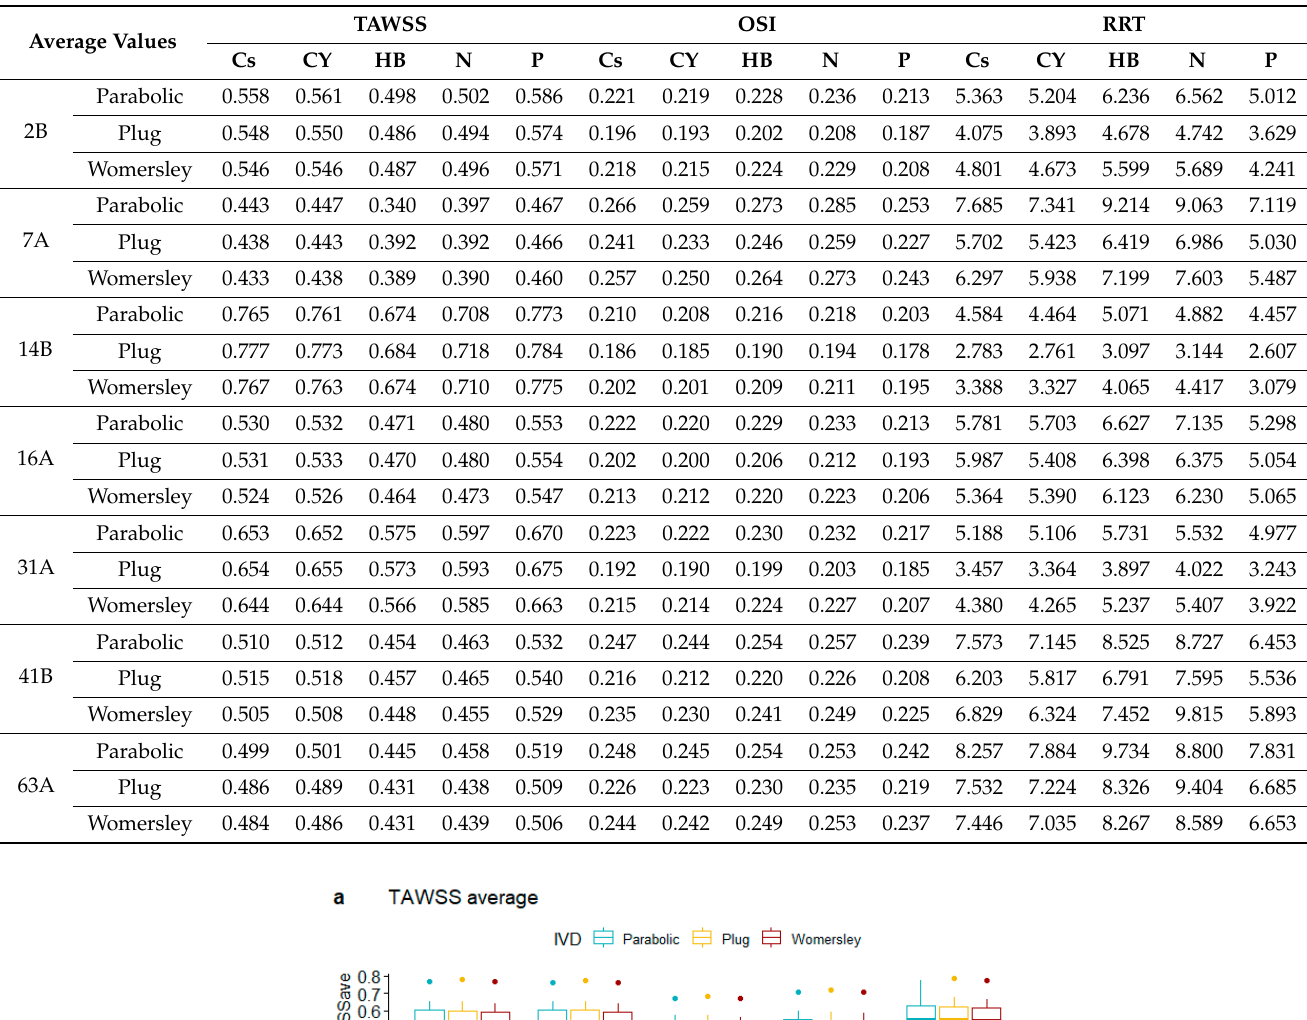
Table 7. Average values and TAWSS, OSI, and RRT.